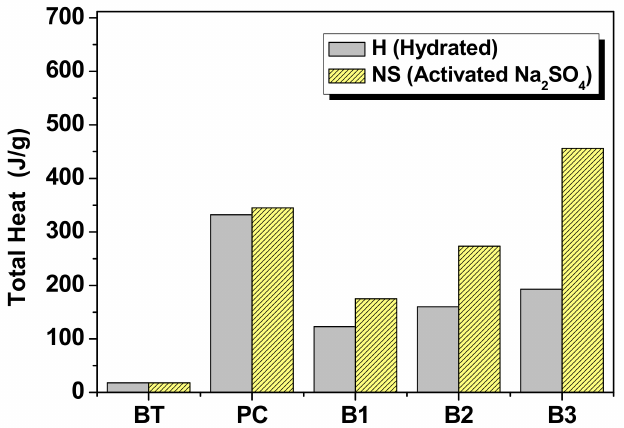
Figure 3. Total Heat (J/g) for the different systems after 120 h of